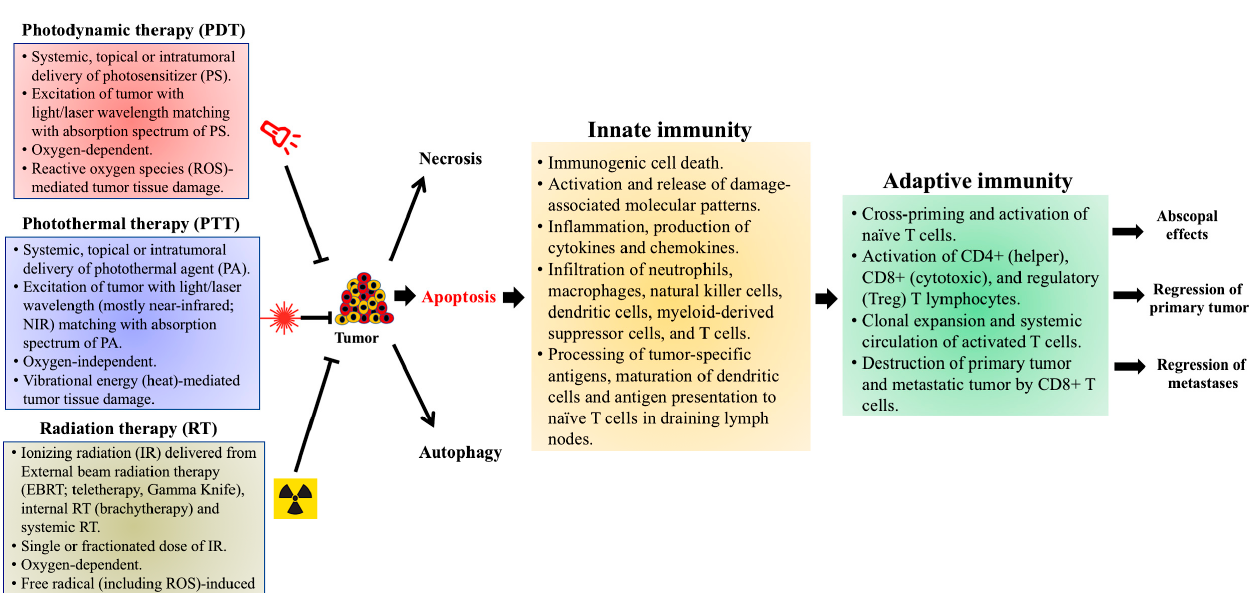
Figure 1. Photodynamic therapy- (PDT), photothermal therapy- (PTT), and radiation therapy (RT)-induced effects on anti-tumor immunity, based on preclinical studies in murine tumor models. Treatment of tumors with PDT, PTT or RT leads to cell death within the primary tumor by apoptotic, necrotic and autophagic mechanisms. Apoptosis induced by these therapies also generates an immune response, referred to as immunogenic cell death (ICD), within the tumor microenvironment (TME). Damage-associated molecular patterns (DAMPs), expressed on the surface of dying cells and released into the TME, promote the recruitment and maturation of antigen-presenting cells (APCs), primarily dendritic cells (DCs). Various cytokines and chemokines (IL-1 β , IL-6 and TNF α ), released by the photodamaged cells, induce local inflammation and recruit cells associated with innate immunity (neutrophils, macrophages, natural killer cells, and mast cells). The DCs engulf and process tumor-specific antigens (TSAs), then migrate to draining lymph nodes (DLNs) to present the processed TSAs to naïve T cells, thereby triggering the adaptive arm of anti-tumor immunity. Activated T cell subsets (CD4+, CD8+ and FoxP3+) undergo clonal expansion and differentiation within the TME, mediating tumor regression via cytotoxic activities of CD8+ cytotoxic T lymphocytes (CTLs). Optimally, these activated T cells may enter the systemic circulation and travel to distant metastases, mediating a more widespread (abscopal) effect. The immunological events discussed here were observed in PDT-treated murine tumor models, but similar mechanisms of anti-tumor immunity have also been reported in pre-clinical studies using PTT and RT (see text for details).